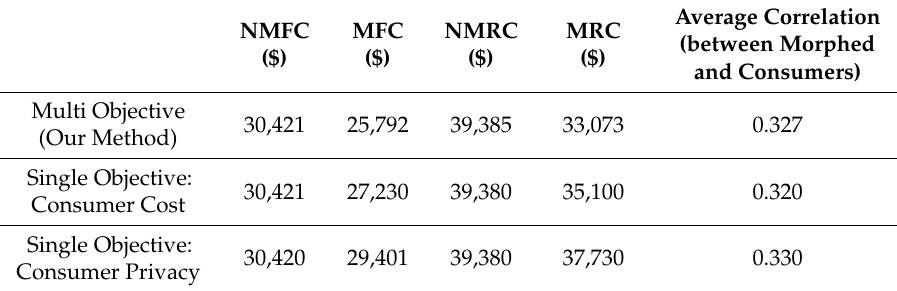
Table 5. Cost ($) and privacy (correlation) measure values computed for Scenario 4 (15